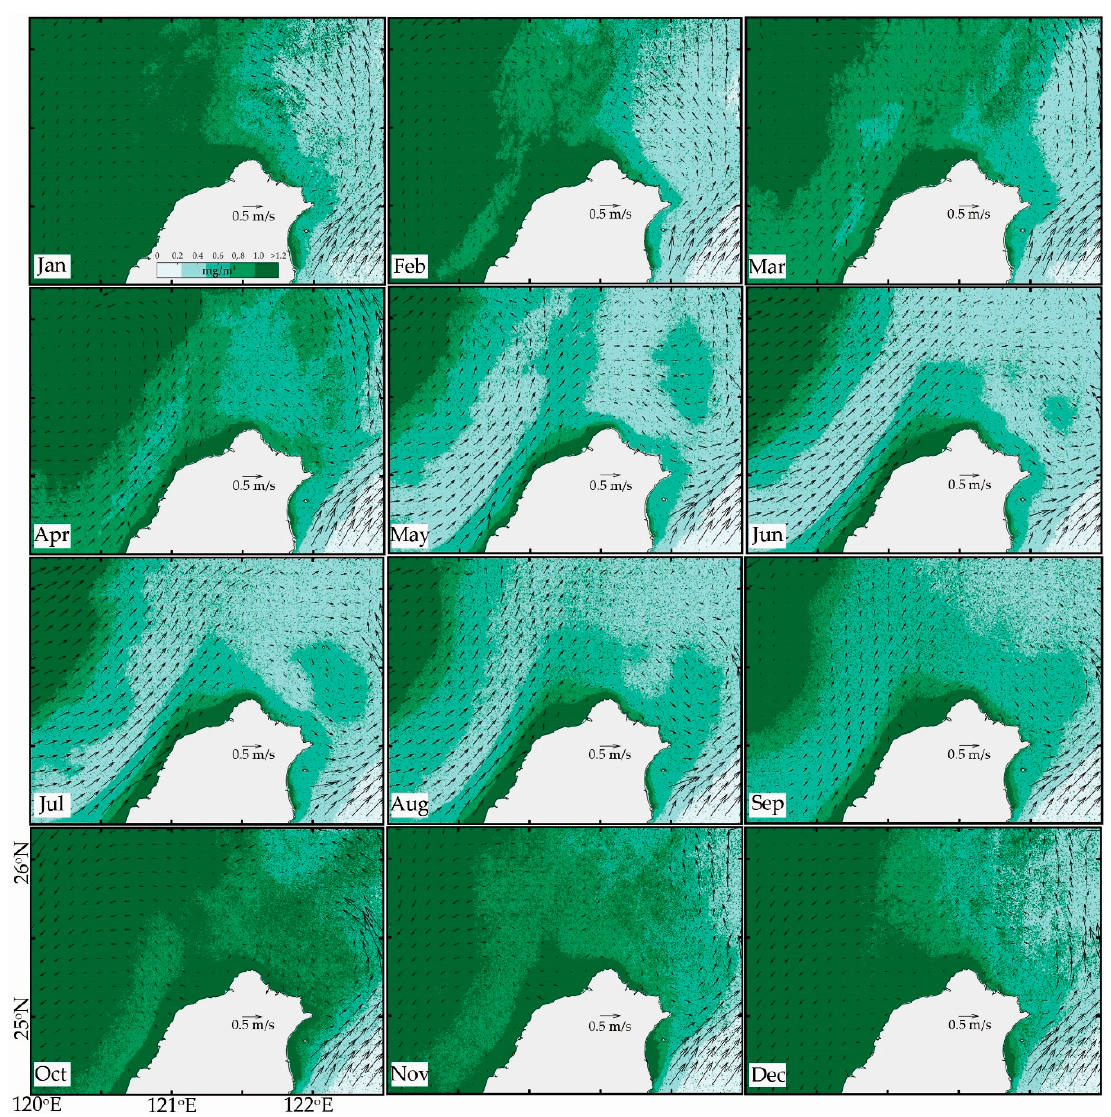
Figure 8. Monthly chlorophyll concentration from December 2014 to May 2020 with the CODAR flow field.